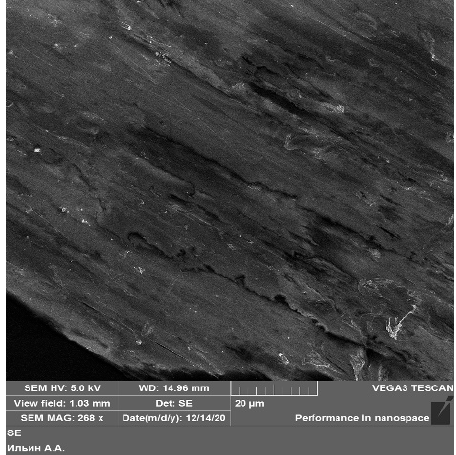
Figure 5. Image of the film with a coating formed by a US-treated composition of PTFE and magnetite stabilized by sodium stearate.